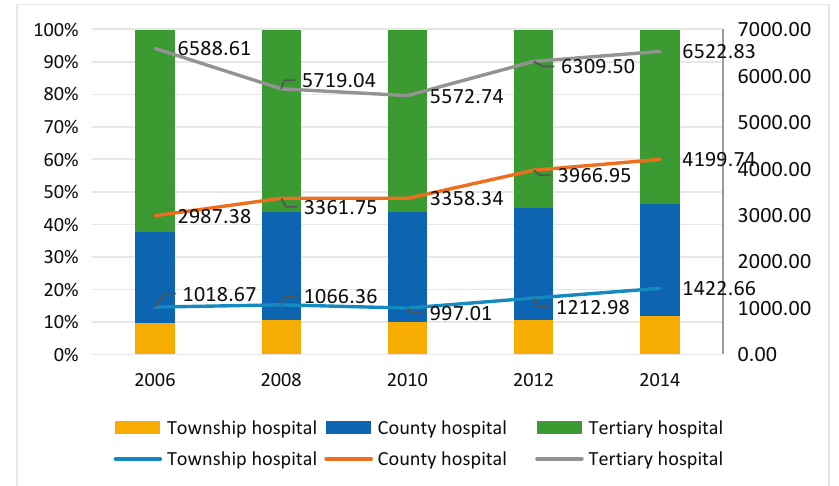
Figure 2. The adjusted hospitalization expense per admission in different levels of medical institutions and distribution (¥). The lines show the adjusted data of hospitalization expense per admission in different levels of medical institutions. The bar chart shows the distribution of the proportion of each level hospital expense in total expense.